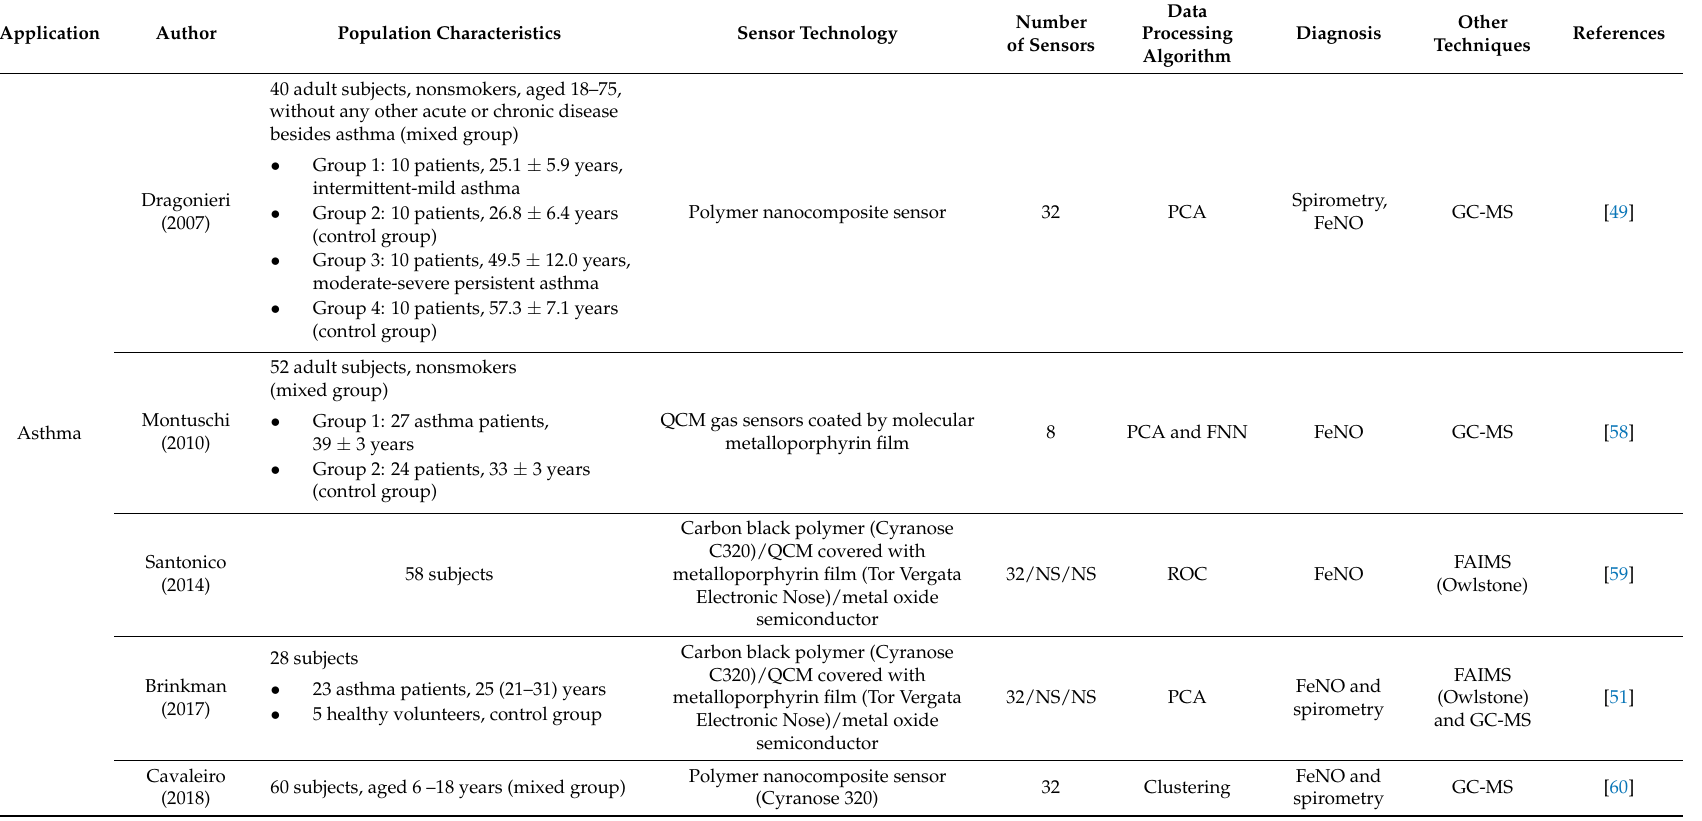
Table 4. Biomedical applications developed using commercial and experimental electronic